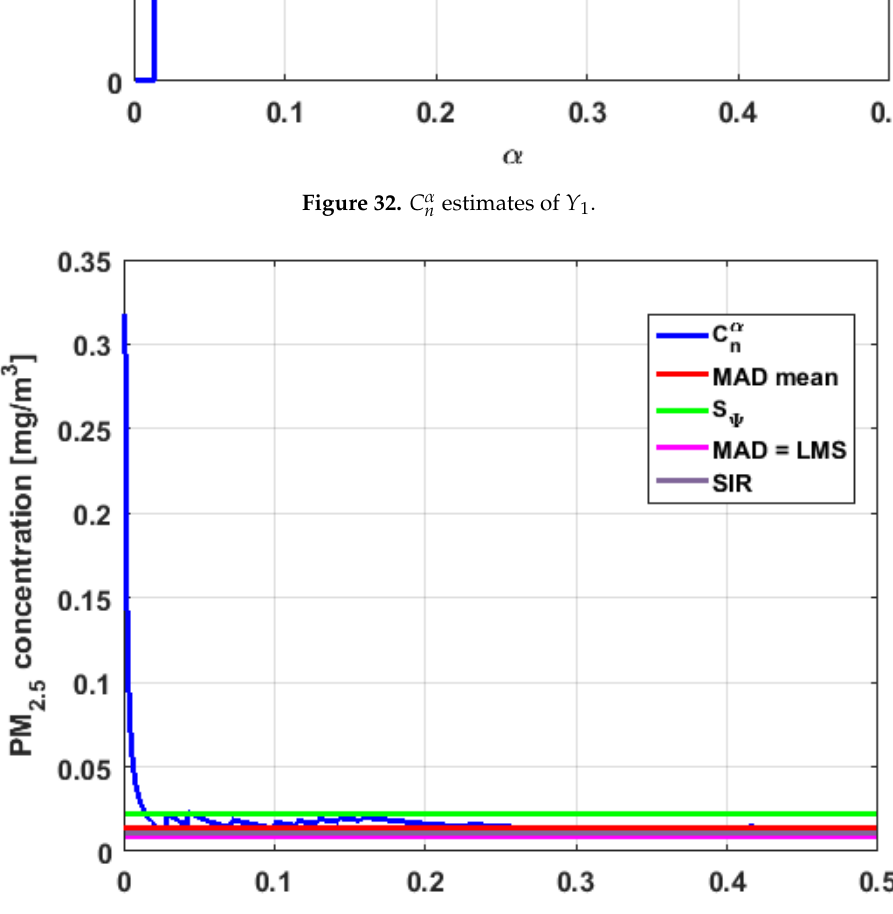
α Figure 33. 𝐶 𝑛𝛼 estimates of 𝑌 2 . Figure 33. C n estimates of Y 2 Figure 33. 𝐶 𝑛𝛼 estimates of 𝑌 2 .